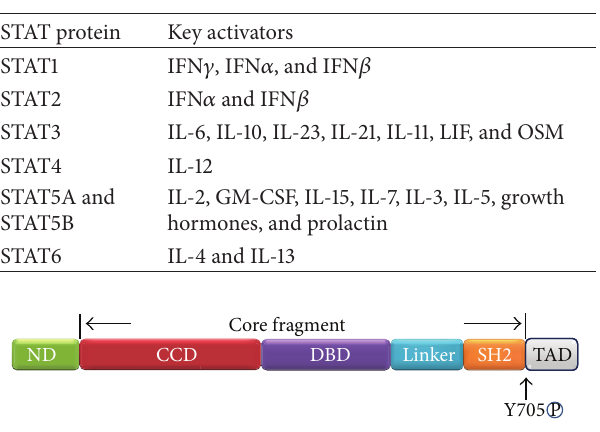
Figure 1: Structure of STAT3. The six domains of STAT3 are N- terminal domain (ND), coiled-coil domain (CCD), DNA-binding domain (DBD), linker domain, SH2 domain, and transcriptional activation domain (TAD). Between SH2 and TAD there is a tail segment that contains the phosphorylation site